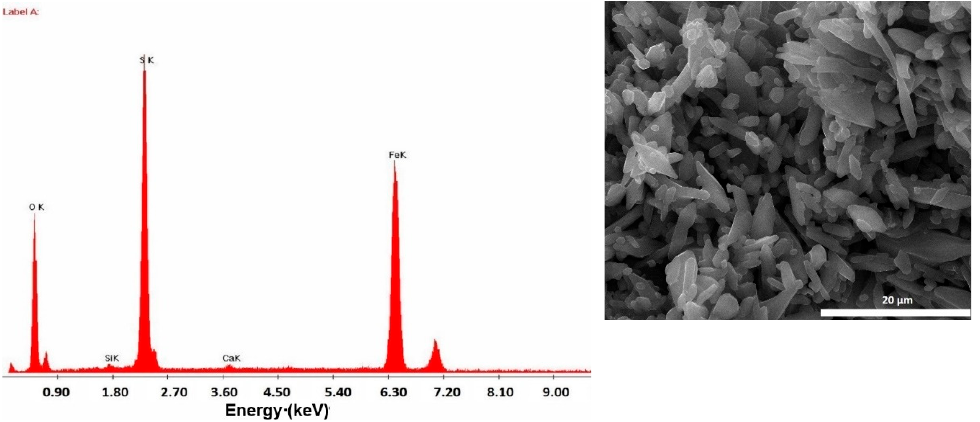
Figure 7. EDX results obtained on the SEM image (inlet) of the MS-ION precursor.